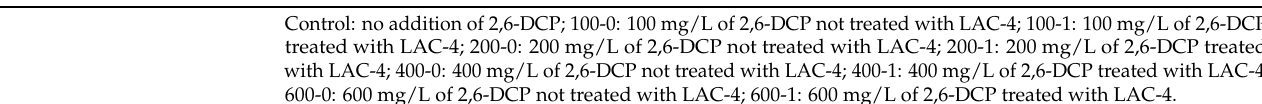
Table 3. Effects of different concentrations of 2,6-DCP on the germination rates of wheat seeds before and after degradation by LAC-4 laccase. Control 100-0